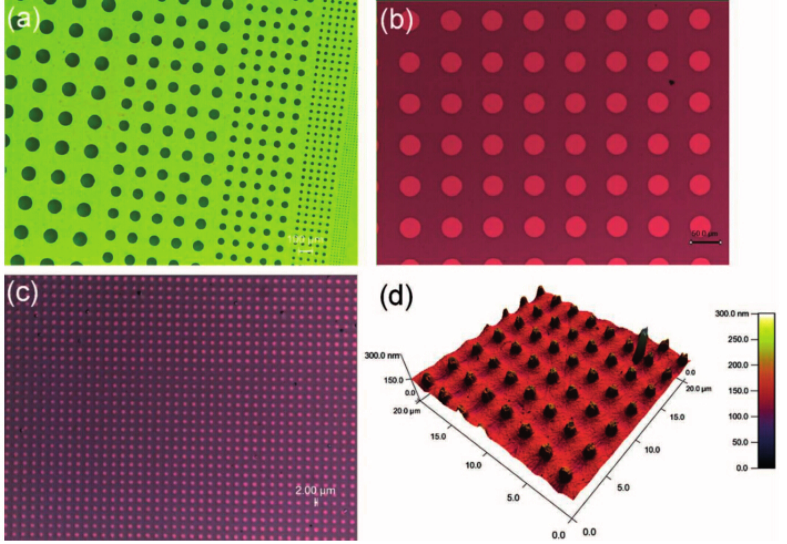
Figure 9. Photographs ( a – c ) of patterned crosslinked P3HT films on glass/ITO/PEDOT:PSS substrates following deep-ultraviolet light (DUV), 254 nm wavelength exposure and solution development; ( d ) 3D AFM (atomic force microscope) image of 2- μ m pillars in a patterned crosslinked P3HT film. Cited from [95]. Copyright 2013,